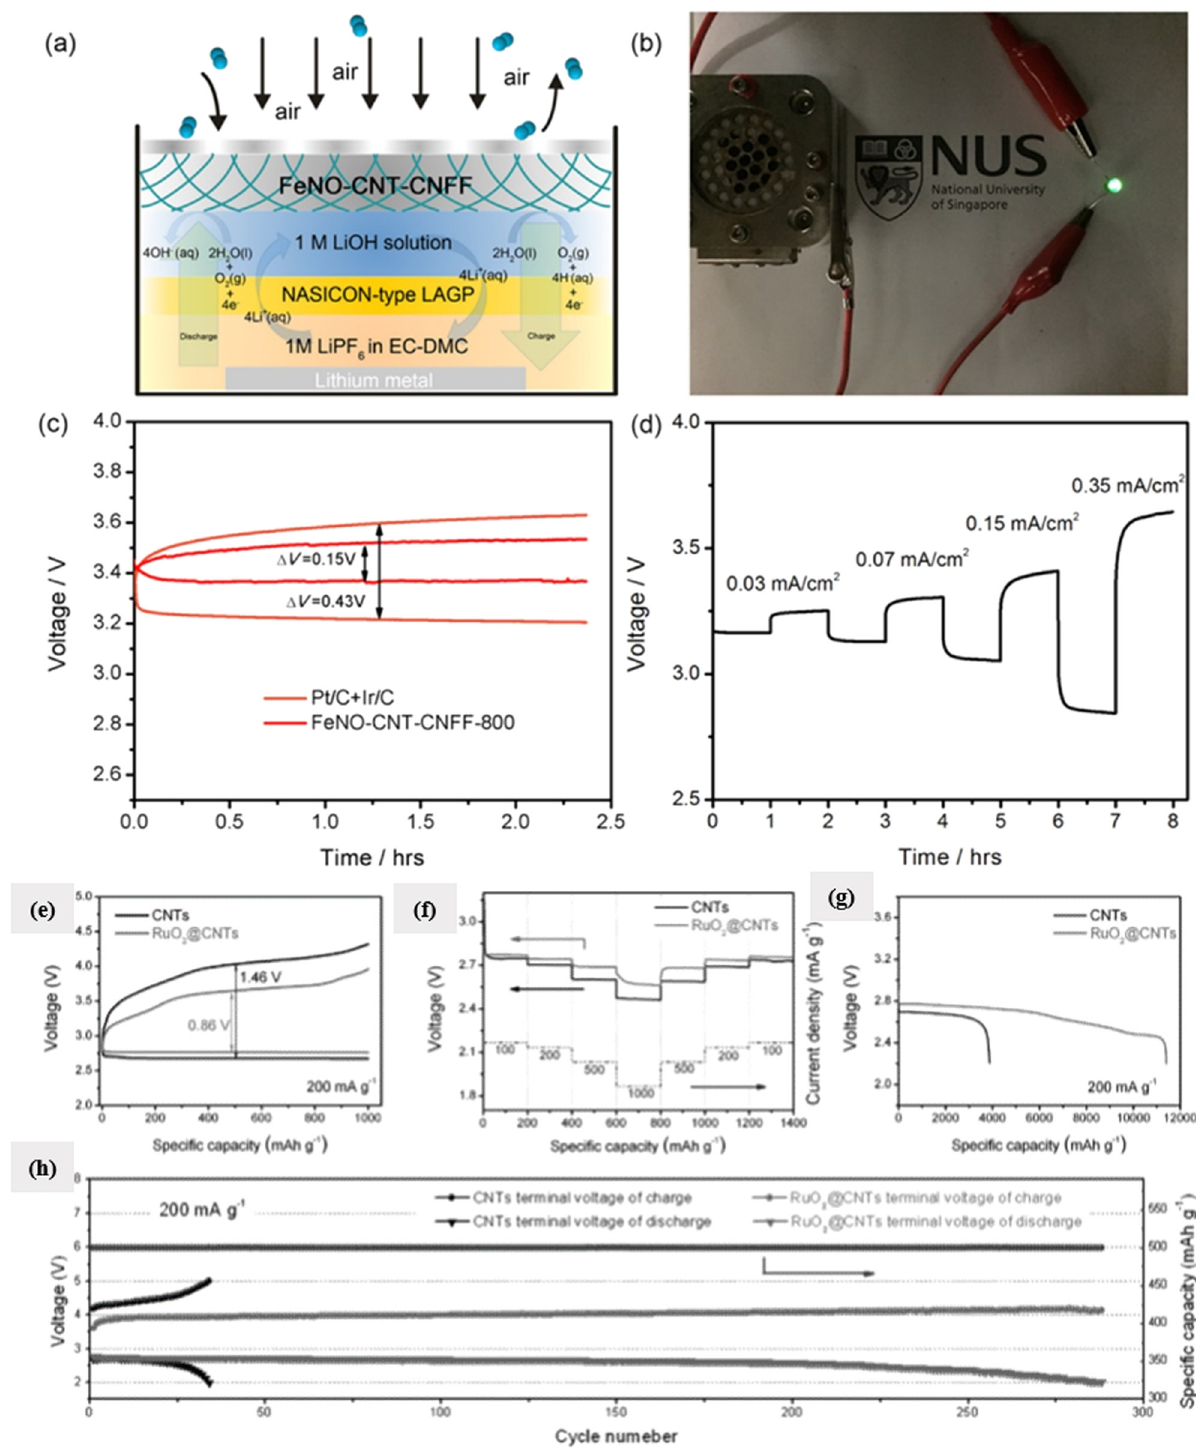
Figure 10: ( a ) Mechanism diagram of rechargeable Li – air battery. ( b ) The picture indicates that a green LED (> 3 V ) can be lightened by the FeNO - VACNT - CNF - based hybrid Li – air battery. ( c ) Comparison of charging and discharging voltage di ff erence between di ff erent catalysts in Li – air batteries. ( d ) Charge – discharge curves of FeNO - VACNT - CNF - based hybrid Li – air battery at di ff erent current densities [ 74 ] .